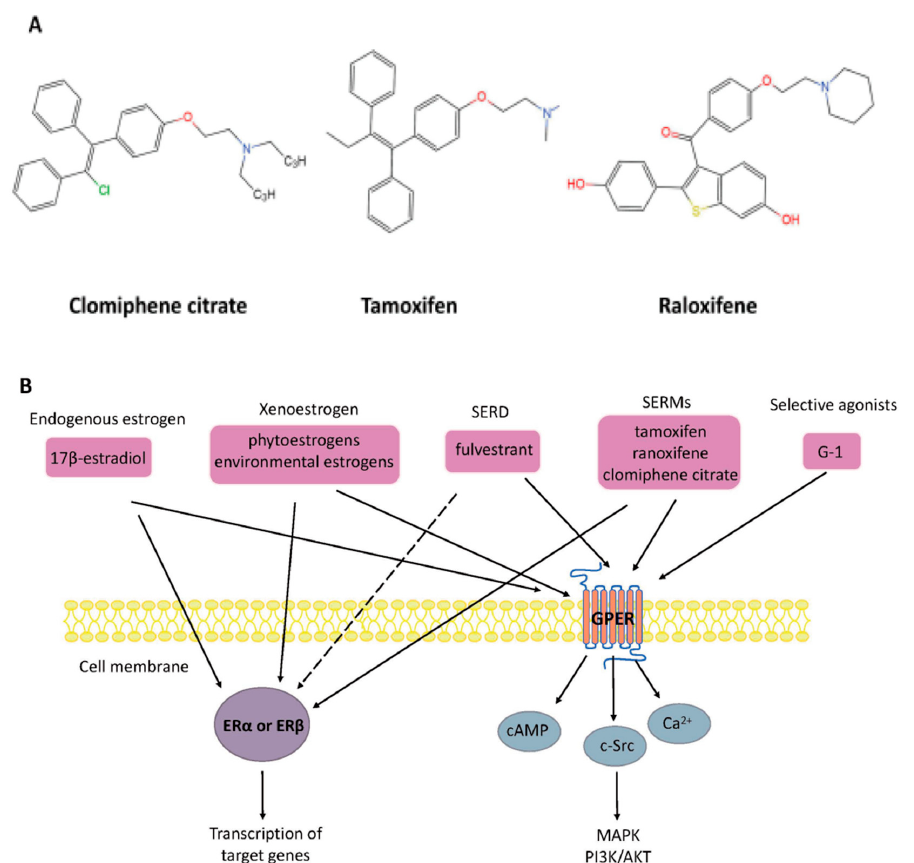
Figure 2. ( A ) Chemical structure of selective estrogen receptor modulators clomiphene citrate, tamoxifen, and raloxifene. ( B ) Nongenomic and genomic estrogen signal transduction pathways. Estrogen receptor ligands include 17 β -estradiol and other compounds. Dashed lines indicate tissue-specific inhibition. SERD, selective estrogen receptor downregulator; SERM, selective estrogen receptor modulators; G-1, 1-[4-(6-bromobenzo[1,3]